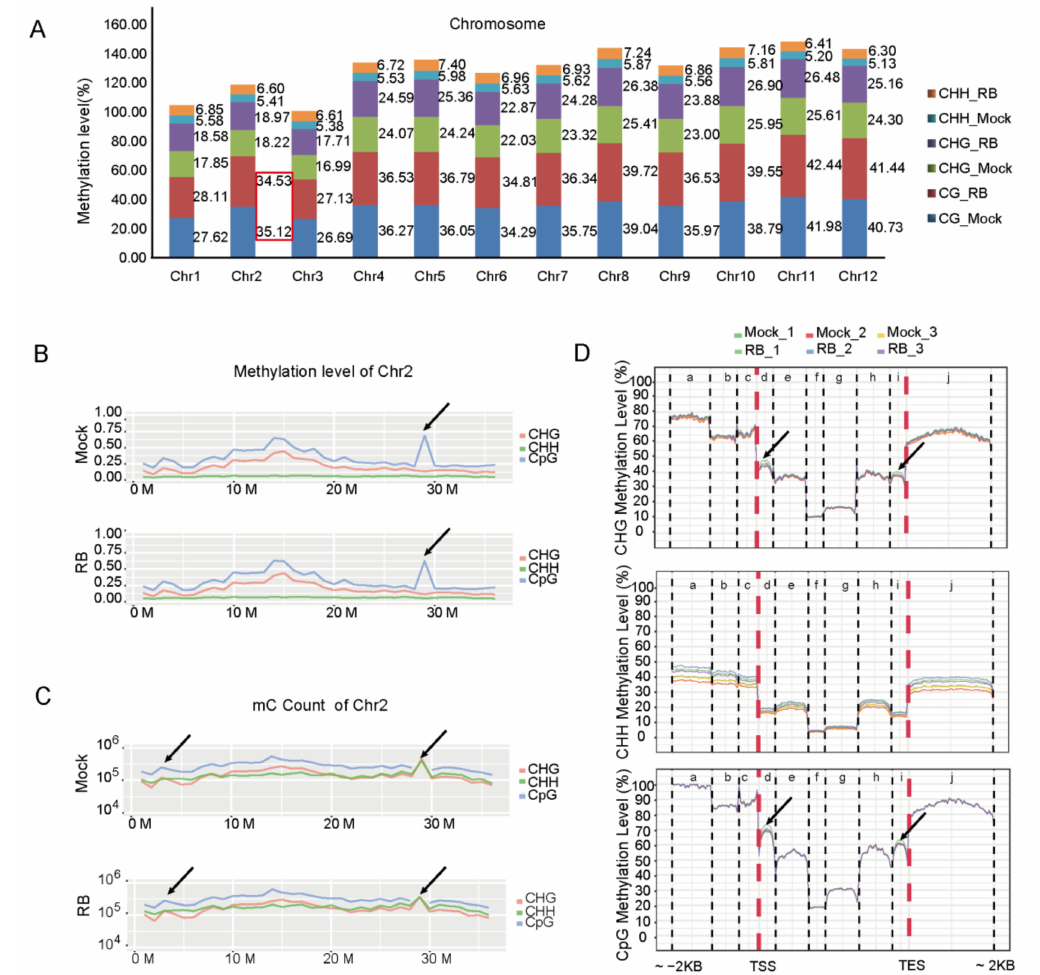
Figure 1. Di ff erential CG and non-CG methylation levels in genomic regions of virus-free or RBSDV-infected rice. ( A ) Levels of CG methylation and non-CG methylation in rice chromosomes. Methylation level: percentage of reads showing mC among all the reads covering the same cytosine site. ( B , C ) The density profiling of methylcytosines ( B ) and mC count ( C ) in chromosome 2. Smoothed lines represent the density (CpG, CHG and CHH) in each context. Black arrows highlight the di ff erences between the Virus-free and RBSDV-infected rice chromosome 2. One biological replicate was shown. Density profiling: mC per million base pairs. ( D ) DNA methylation levels of gene body and promoter regions (a: Distal promoter. b: Intermediate promoter. c: Proximal promoter. d: First exon. e: First intron. f: Internal exon. g: Internal intron. h: Last intron. i: Last exon. j: Downstream). Methylation levels of CpG, CHG, and CHH are shown. Transcription start site (TSS) and transcription end site (TES) are